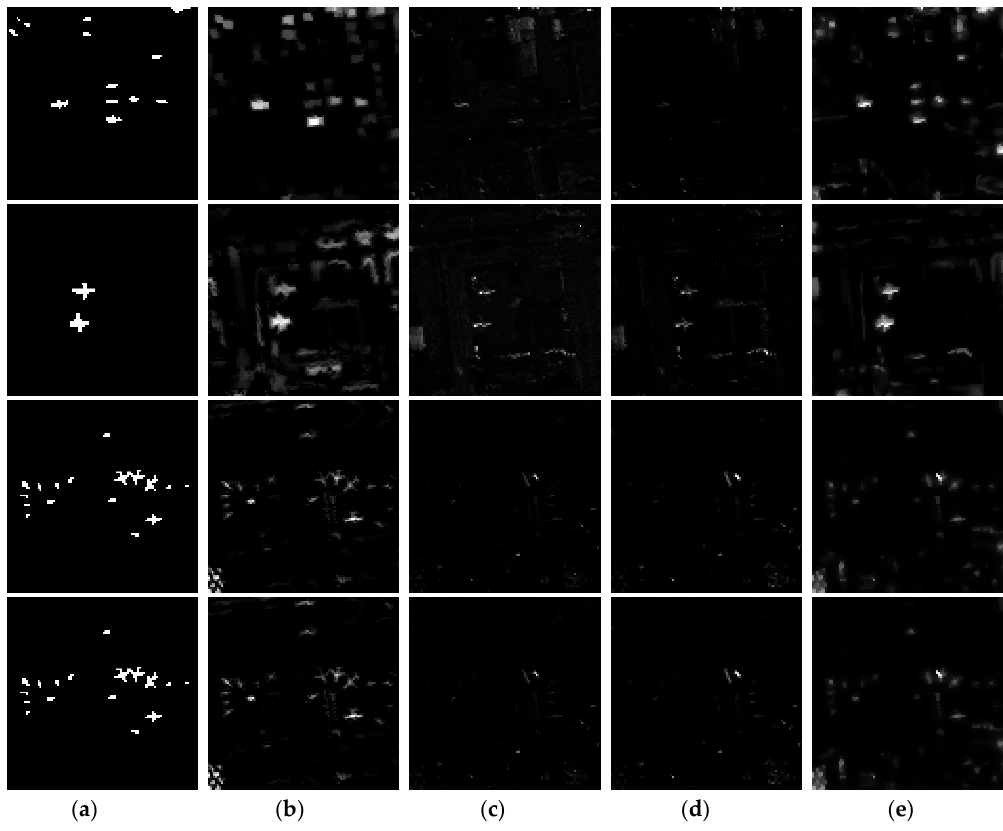
Figure 4. ABU-Airport detection map of the compared methods. ( a ) Reference map, ( b ) MPAF, ( c ) RX, ( d ) FrFE-RX, ( e ) AED.